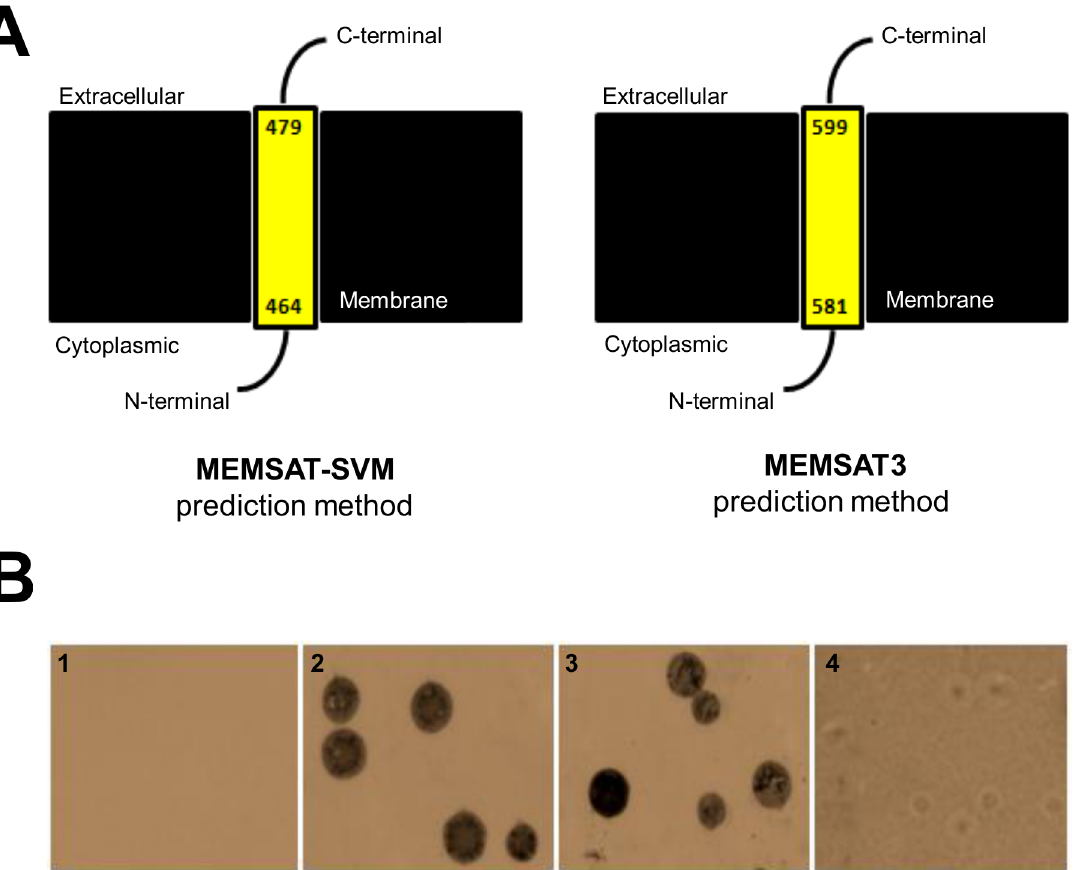
Fig 2. Hypothetical and experimental evidence of Mm19 surface exposure. (A) Schematic representation of the secondary structure of Mm19 protein as predicted by PSIPRED based on PSI-BLAST. Using MEMSAT-SVM, a segment of 464 amino acids, including the N-terminal region of the Mm19 nuclease protein, was predicted to be located in the cytoplasm. The C-terminal 167 residues were predicted to be exposed to the extracellular milieu, while 15 amino acid residues were embedded within the membrane. A similar topology was predicted by MEMSAT3 but with a few differences in the segments lengths (cytoplasmic segment, 581 aa; transmembrane segment, 18 aa; extracellular segment, 47 aa). (B) Surface expression of M . meleagridis Mm19 as revealed by colony blotting. M . meleagridis colonies growing on agar plates were left untreated or subjected to trypsin digestion then imprinted onto nitrocellulose discs. The anti-GST (panel 1) and the specific polyclonal anti- M . meleagridis (panel 2) sera were used as negative and positive controls, respectively. The reactivity of anti-GST-Mm19 serum against non- and trypsin-treated M . meleagridis colonies is shown in panels 3 and 4, respectively. Colored imprints of colonies were observed under a microscope at 100 x